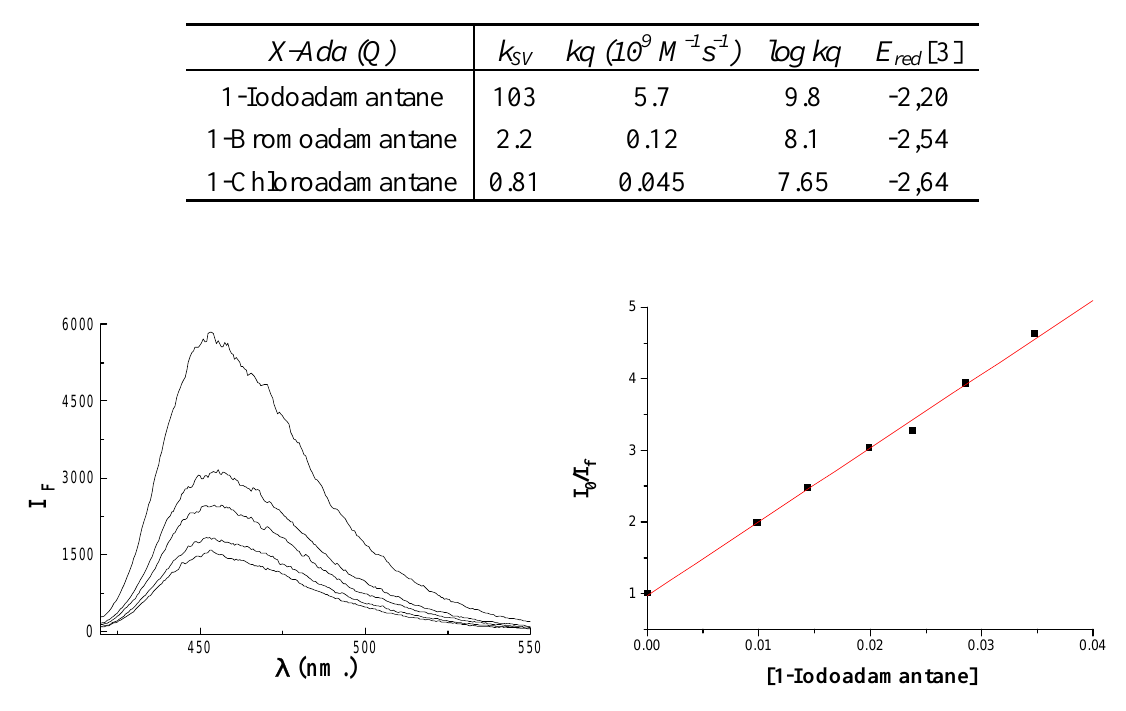
Figure 1. Quenching of 2-naphtoxide ion by